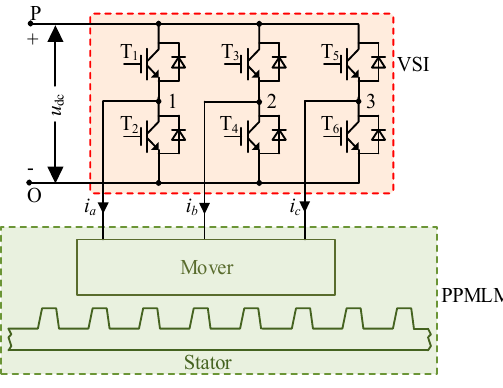
Figure 2. Studied PPMLM traction system.